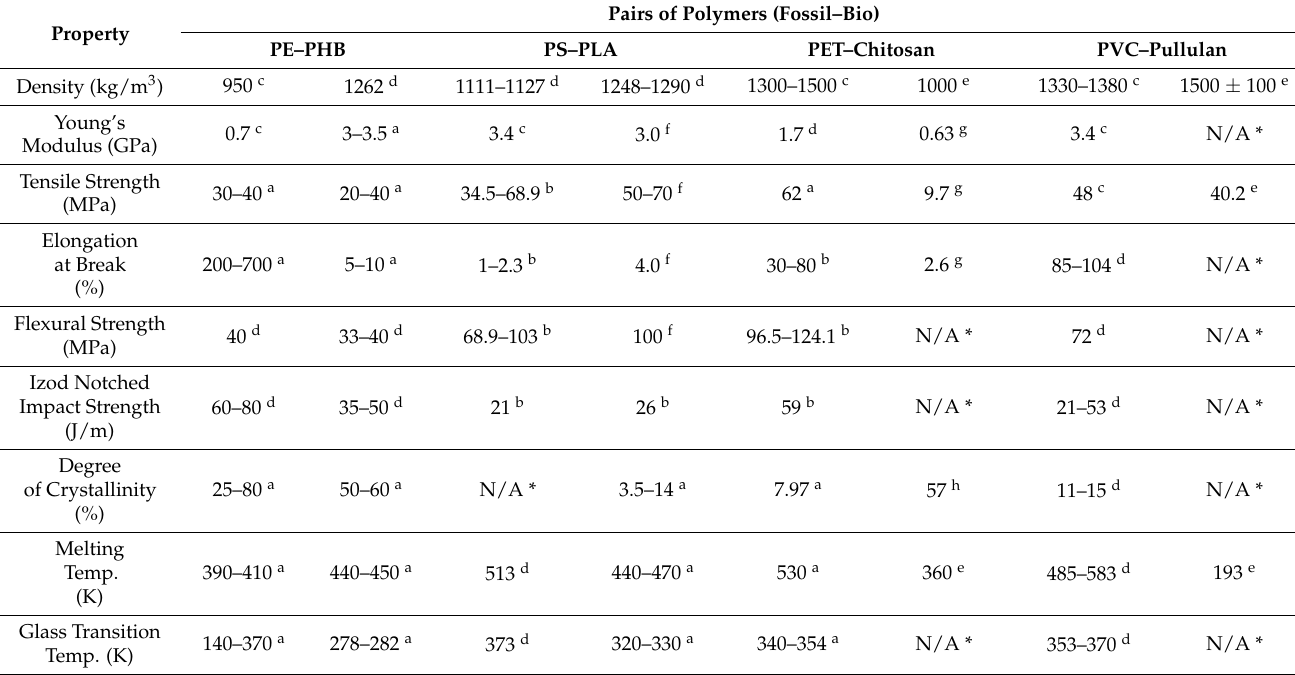
Table 1. Selected properties of all the polymers discussed in this